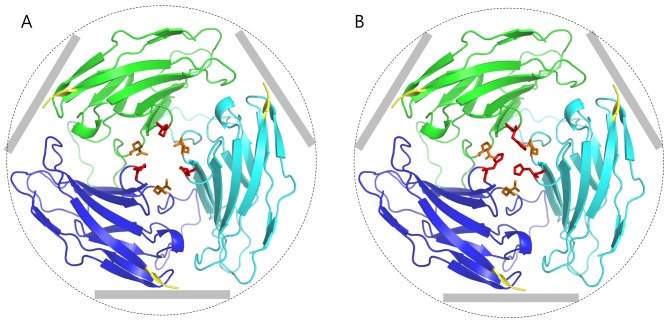
Trimer structure model of ig-like domains of ILDR1.The red and orange residues are the 69th and 97th residue, respectively. The cell membrane of each epithelial cell is located after the C-terminus (red color). The grey bars schematically represent the cell membranes surrounding the tricellular junction (dashed circle). Both 69th residues and 97th residues are gathered near interface region, which explains why p.P69H and p.R97Q mutations weakening the localization. (A) wild type trimer (B) p.P69H mutant trimer.